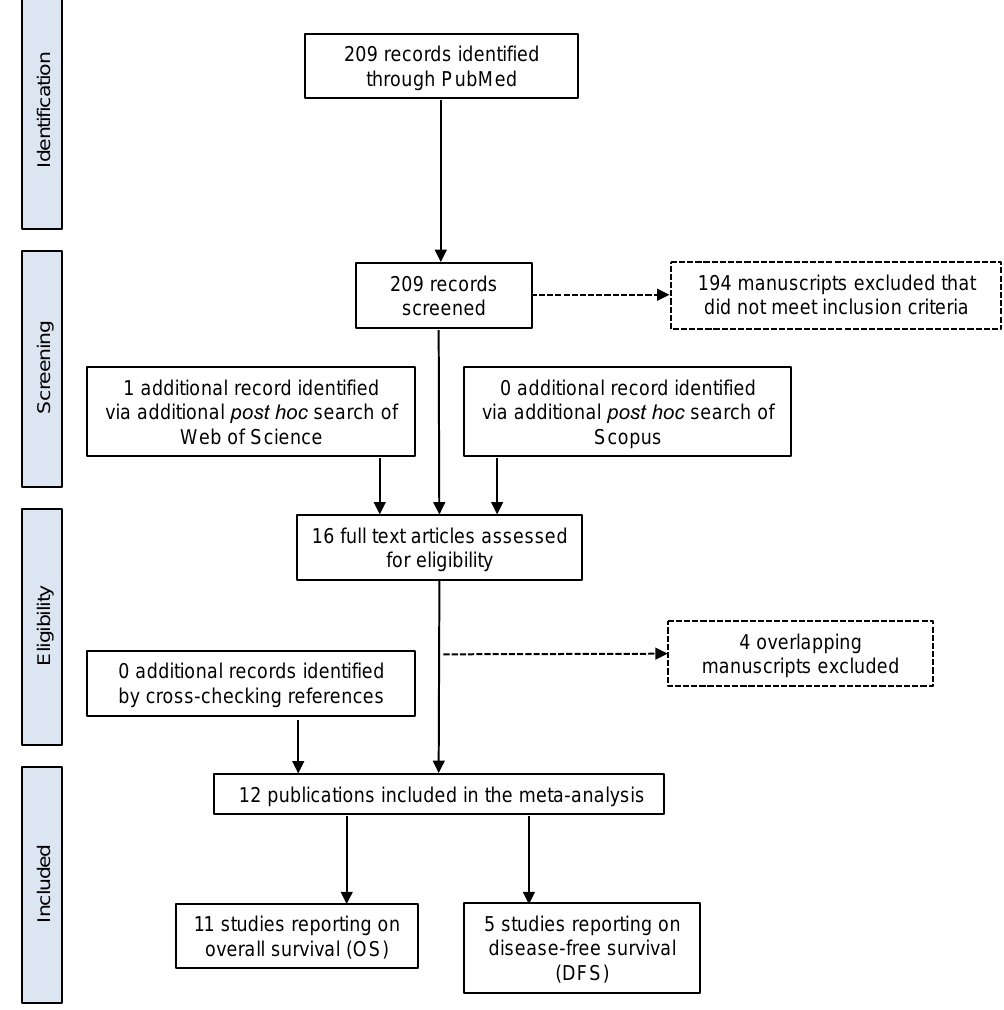
Figure 1. Flow diagram of the study identification and selection process for inclusion in the meta-analysis of overall and disease-free survival by HPV-status for patients with sinonasal squamous cell carcinoma.